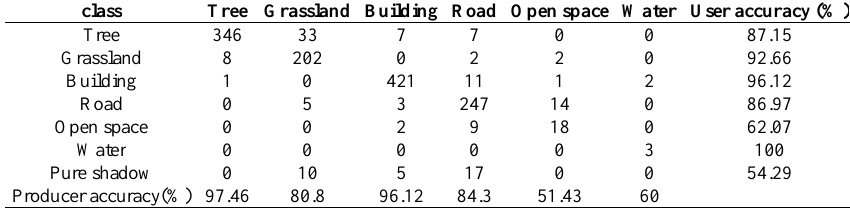
Table 2. The confusion matrix of classification on region B